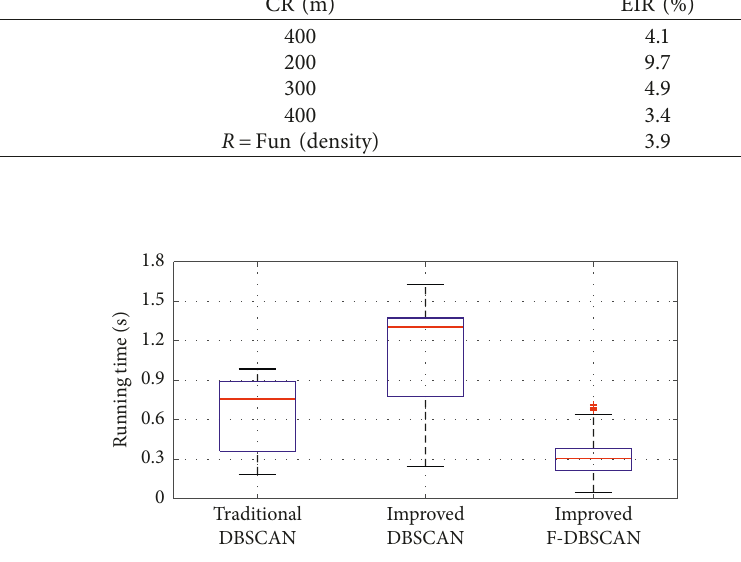
Figure 15: Comparison of running time among different DBSCAN algorithms.